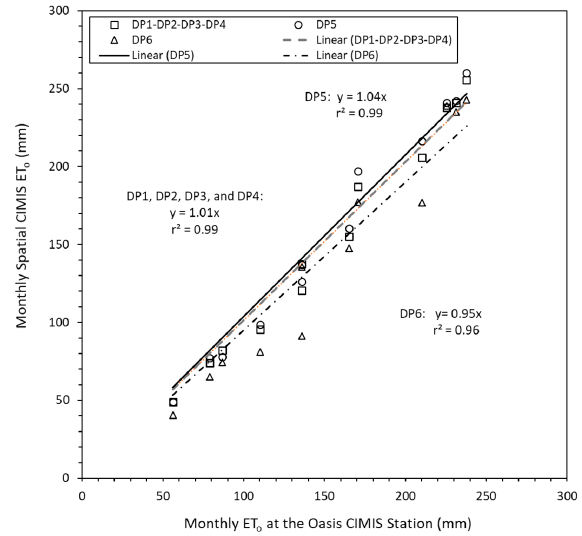
Figure 10. Monthly Spatial CIMIS ET o of the experimental date palms versus monthly ET o at the Oasis # 136 CIMIS station. The difference of spatial CIMIS ET o at DP1-DP4 sites was less than 1%, and as a result only one set of ET o was used to represent the spatial CIMIS ET o of these four sites. The monthly